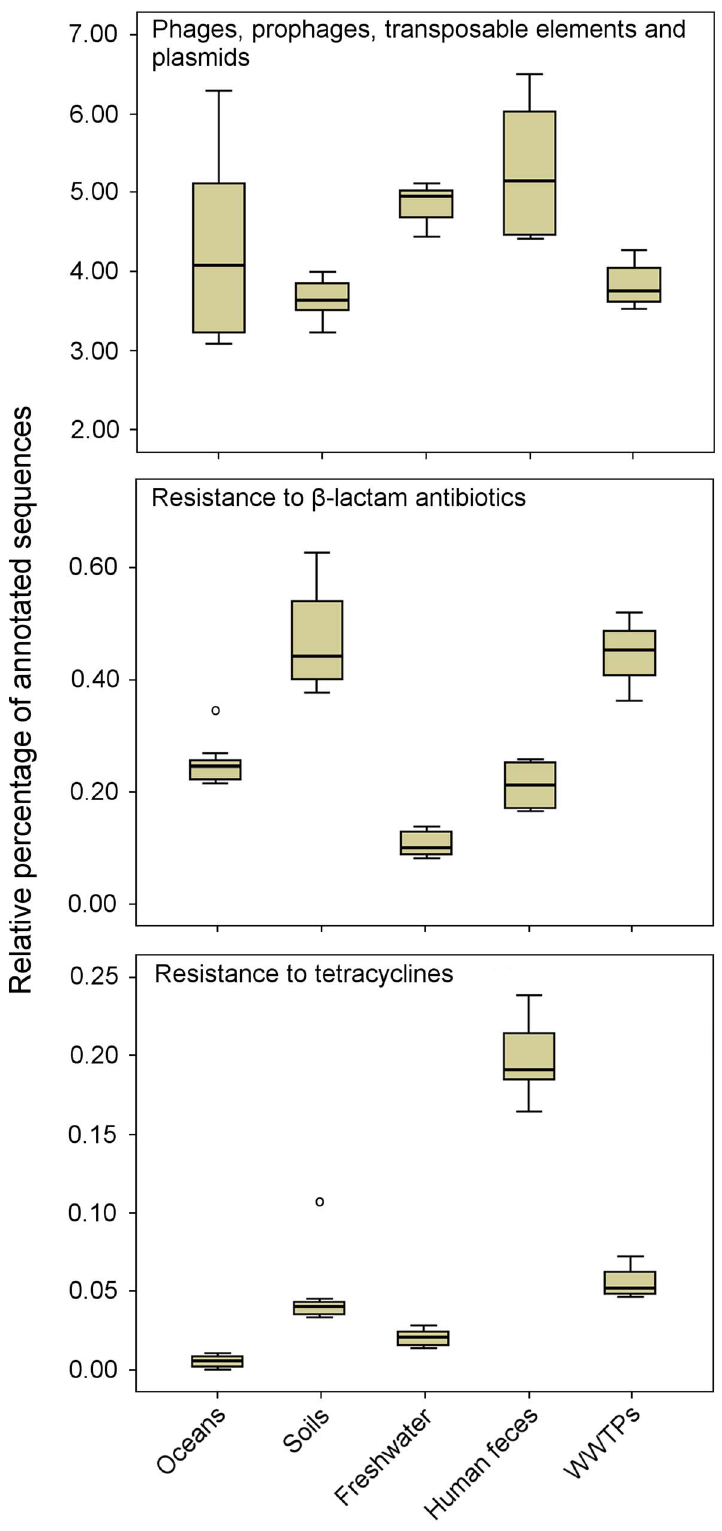
Figure 2. Metagenomic exploration of the resistome from human and environmental sources. Relative distribution of reads assigned to three functional subsystems among 27 metagenomes (based on MG-RAST annotation, E -value = 10 2 5 ). Data are normalized by the total annotated sequences and are expressed as a percentage. The horizontal line in each box plot represents the mean of the relative distribution in each of the five environments (oceans, soils, freshwater, human feces, and WWTPs). The 27 metagenomes used for the analysis are available at http://metagenomics. anl.gov [13]. Accession numbers for oceans: 4441573.3, 4441574.3, 4441576.3, 4441577.3, 4441591.3, and 4443729.3; soils: 4441091.3, 4445990.3, 4445993.3, 4445994.3, 4445996.3, and 4446153.3; freshwater (rivers): 4511251.3, 4511252.3, 4511254.3, 4511255.3, 4511256.3, and 4511257.3; human feces: 4440595.4, 4440460.5, 4440611.3, 4440614.3, 4440825.3, and 4461119.3; and WWTPs: 4455295.3, 4463936.3, and 4467420.3. doi:10.1371/journal.ppat.1004219.g002 PLOS Pathogens |